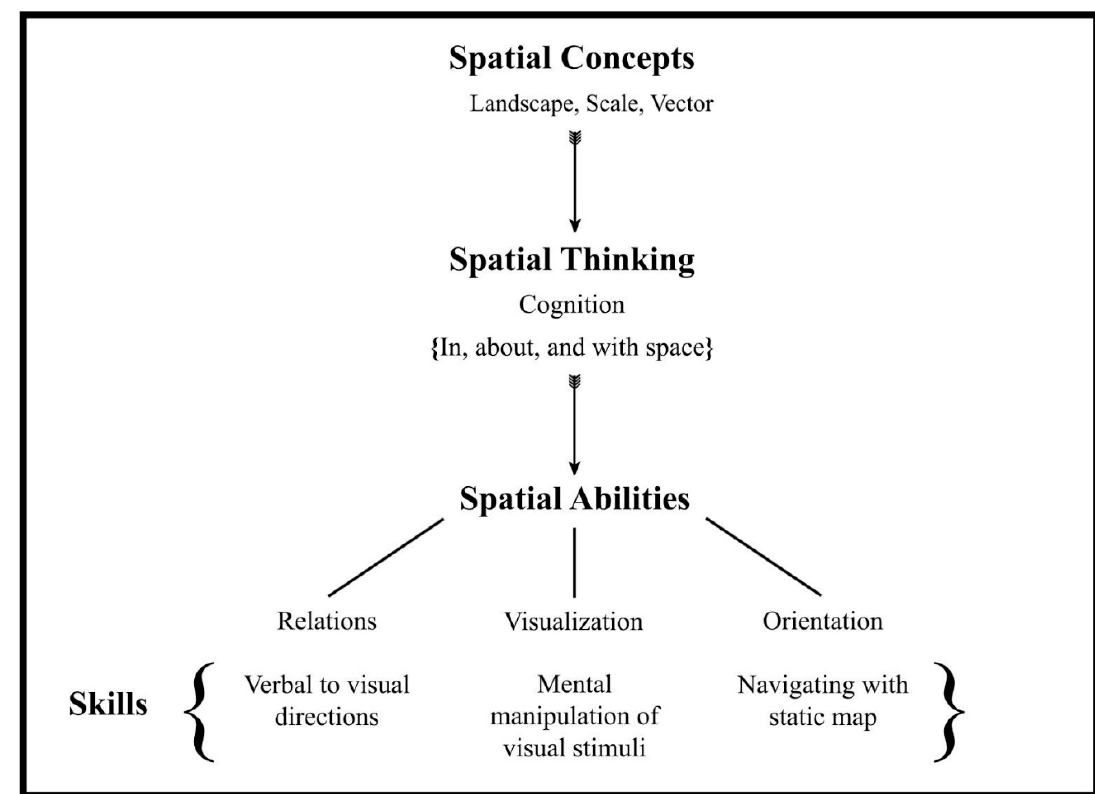
Figure 3. A diagram showing how spatial concepts and thinking are able to enhance one’s spatial abilities and